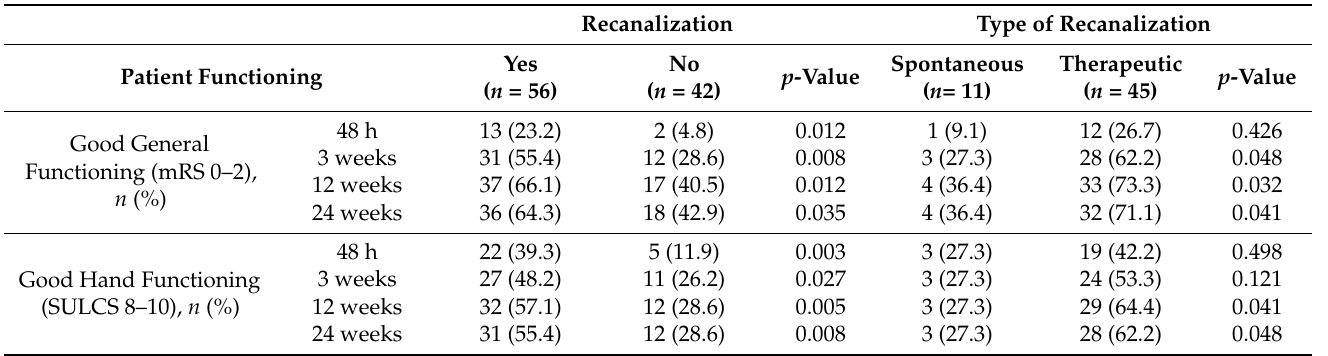
Table 4. Patient functioning according to the occurrence of successful recanalization and the type of recanalization. Recanalization Type of Recanalization